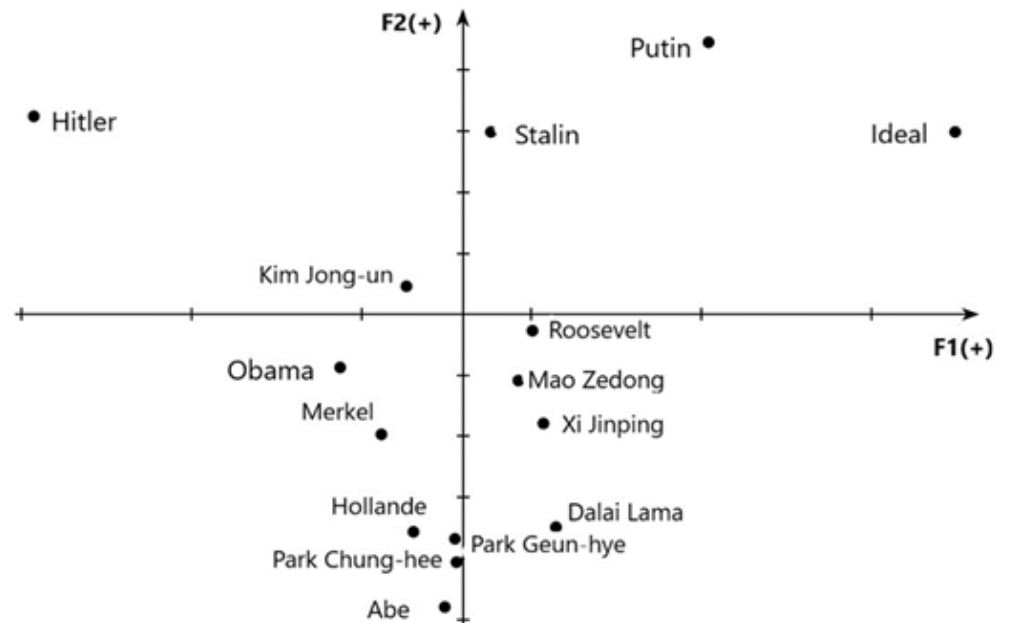
Figure 1. Positions of the images of world political leaders: F1—morality, F2—charisma.